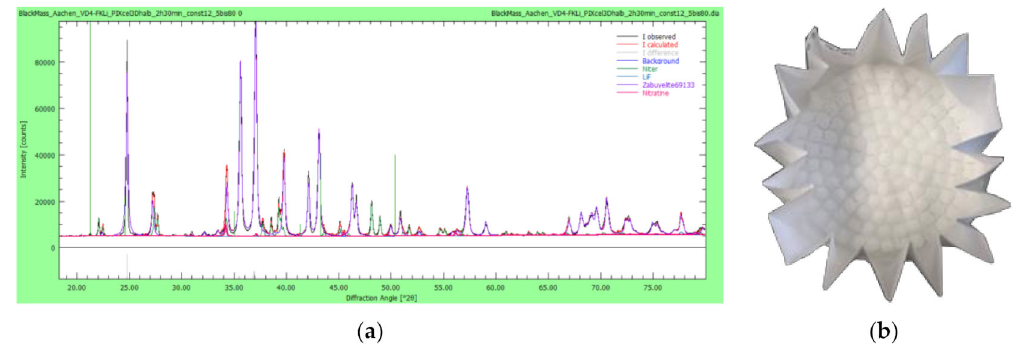
Figure 11. XRD analysis of VD4’s lithium filter cake ( a ). Main phases detected comprise Li 2 CO 3 , and in smaller shares LiF, KNO 3 , and NaNO 3 . On the right side ( b ), a visualization of extracted lithium carbonate can be